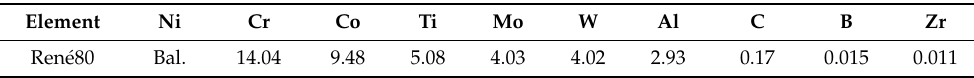
Table 1. Composition of René80 in wt.% .